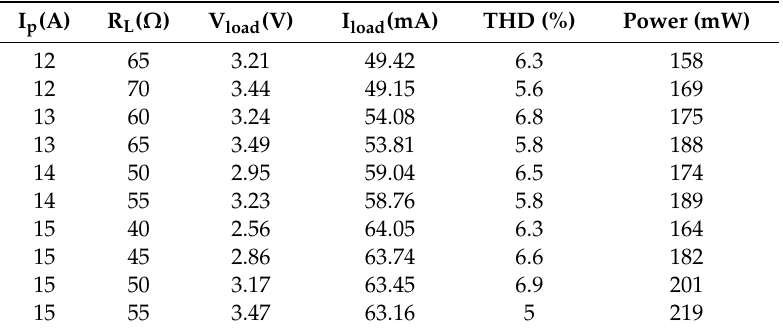
Table 1. Harvester configurations for a particular / specific set of